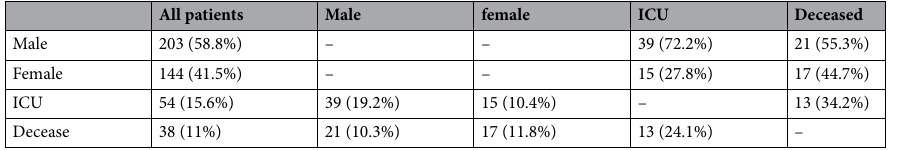
Table 1. Overview of the patient characteristics; each absolute number is also represented as percentage of group defined by the column.